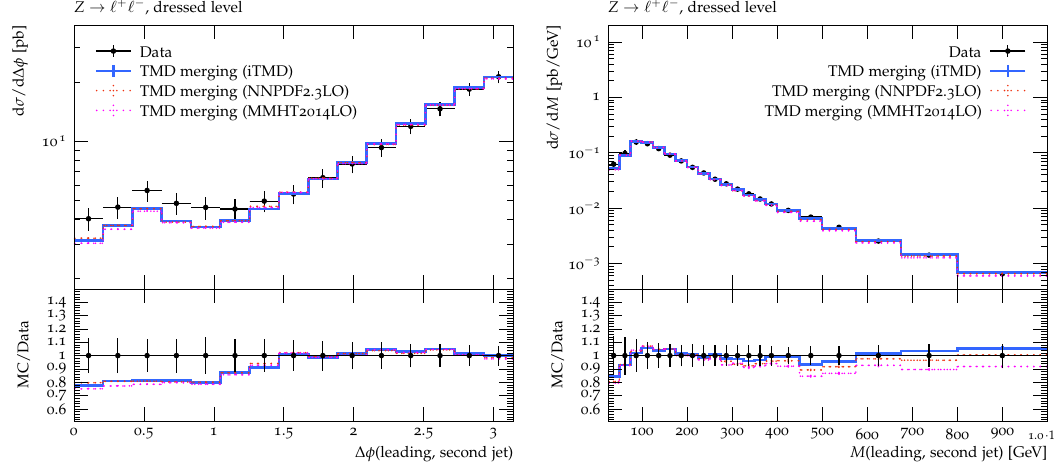
Figure 36 . Di-jet azimuthal separation (left) and di-jet mass (right) distributions for Z + ≥ 2 jets events: PDF sensitivity.